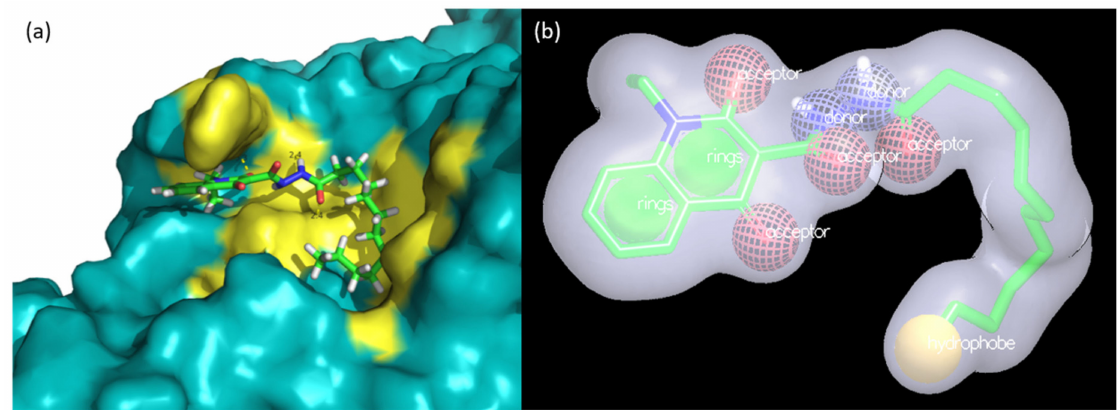
Figure 7. ( a ) Well classified and reliable pose of 1 within allosteric Cavity 7 of GSK-3 β (1PYX.pdb), obtained by Glide docking software. Image produced in Pymol [22]. ( b ) Conformational pose of 1 presented by vROCS, showing its shape (in transparent grey) and its color chemical features (aromatic rings in green, hydrogen bond acceptors in red, hydrogen bond donors in blue, and hydrophobic groups in